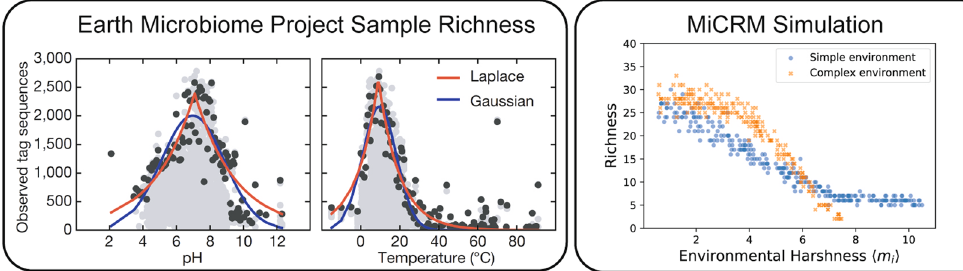
Figure 2. Relationship between diversity and environmental harshness is modulated by environmental complexity. Left: Gray dots are the number of distinguishable strains observed in each sample of the EMP, plotted vs. pH and temperature. Black dots represent the 99th percentile of all communities at a given pH or temperature. Colored lines are fits of a Laplacian and a Gaussian distribution to the 99the percentile points. Reproduced from Figure 2 of the initial open-access report on the results of the EMP 1 . Right: The number of species surviving to steady state in simulated communities, plotted vs. environmental harshness. Harsher environments at extreme pH or temperature were simulated by increasing the total amount of resource consumption m i required for growth (by the same amount for all species). Blue squares are simulation results when all the energy was supplied via a single resource type, while orange circles are simulations where the incoming energy was evenly divided over all 90 possible resource types. See main text and Methods for simulation